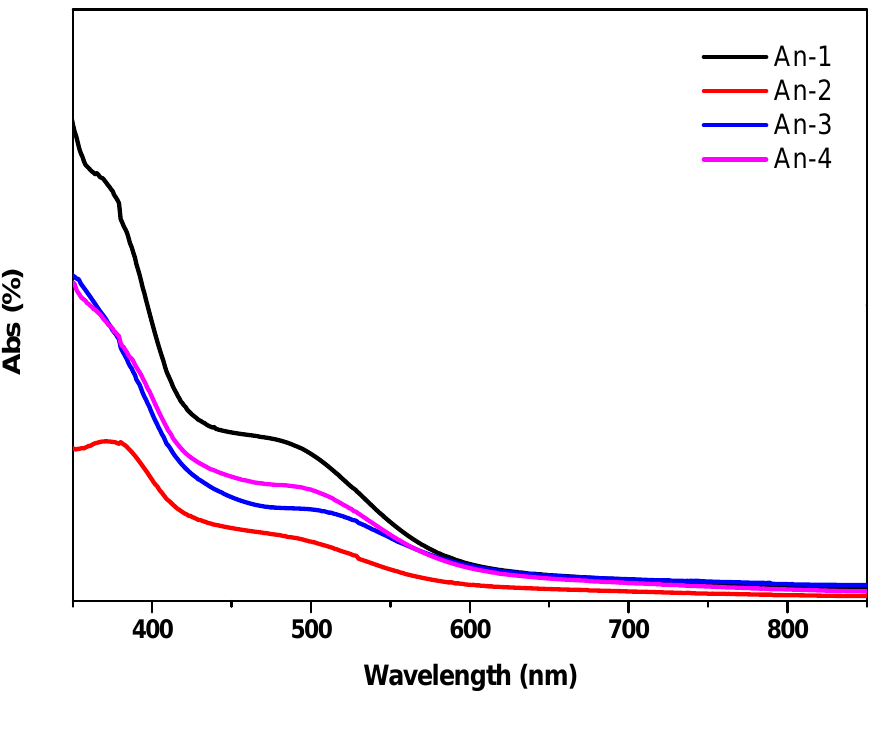
Figure 3. Absorption spectra of the dyes on TiO